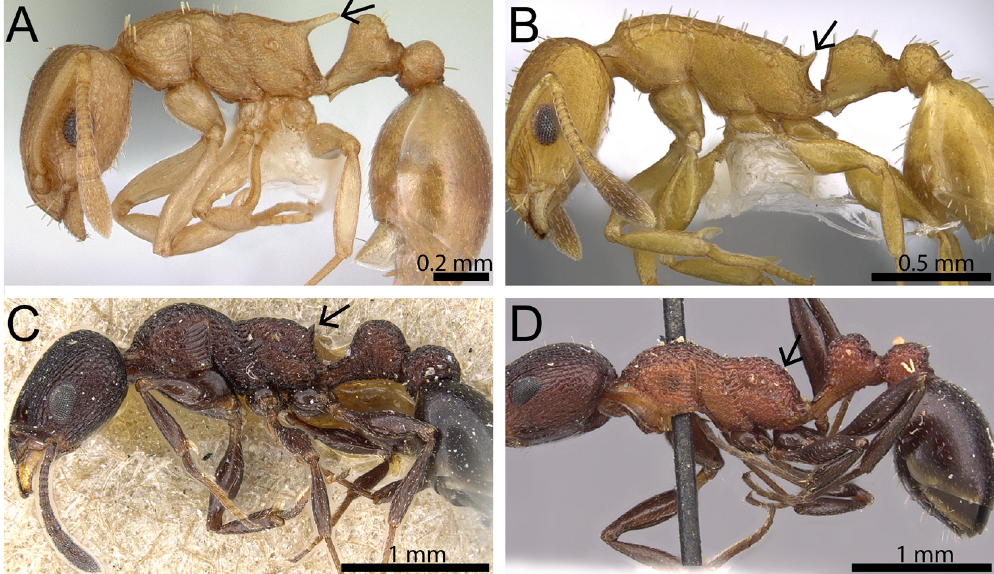
Fig. 4. Body in profile. A . Nesomyrmex evelynae (Forel, 1916) (CASENT0178298). B . N. angulatus (Mayr, 1862) (CASENT0922010). C . N. simoni (Emery, 1895) (CASENT0904790). D . N. braunsi (Forel,